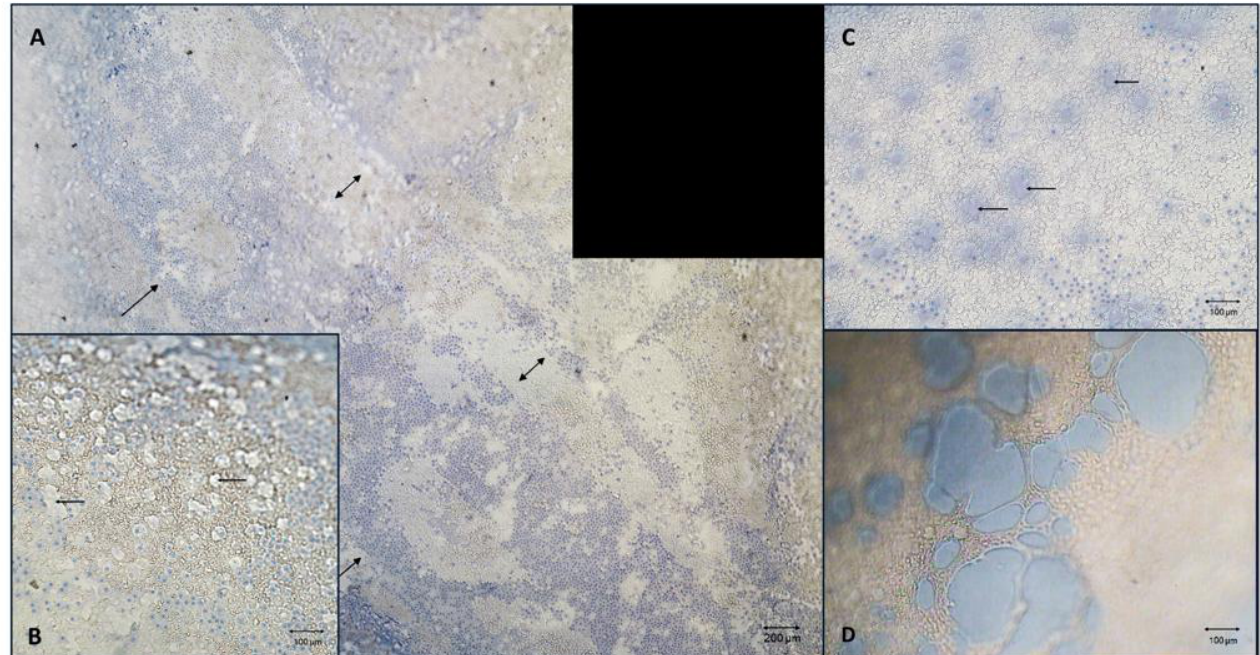
Figure 3. ( A ) Group C, 40× magnification, Trypan Blue/V9, after 72 h of storage, blending of two images. Long area (approximately 5 mm) of localized mortality with well-defined margins (arrows) located in the middle periphery of the membrane. This shape of mortality was also observed on membranes stored in other groups. ( B , C ) Group C, 100× magnification, Trypan Blue/V9, after 72 h of storage. Diffuse presence of Trypan Blue positive cells and uncovered areas (arrows) homogeneously distributed throughout the Descemet membrane endothelial surface. ( D ) 100× magnification, Trypan Blue/sucrose, preserved at 4 °C, archive photo (2010). After being retrieved from the morgue, the tissue was preserved in a vial with tissue culture medium and mistakenly put in direct contact with an ice pocket. After 12 h of preservation, the endothelium showed circular areas with absence of cells and a high percentage of scattered mortality throughout the endothelial surface.